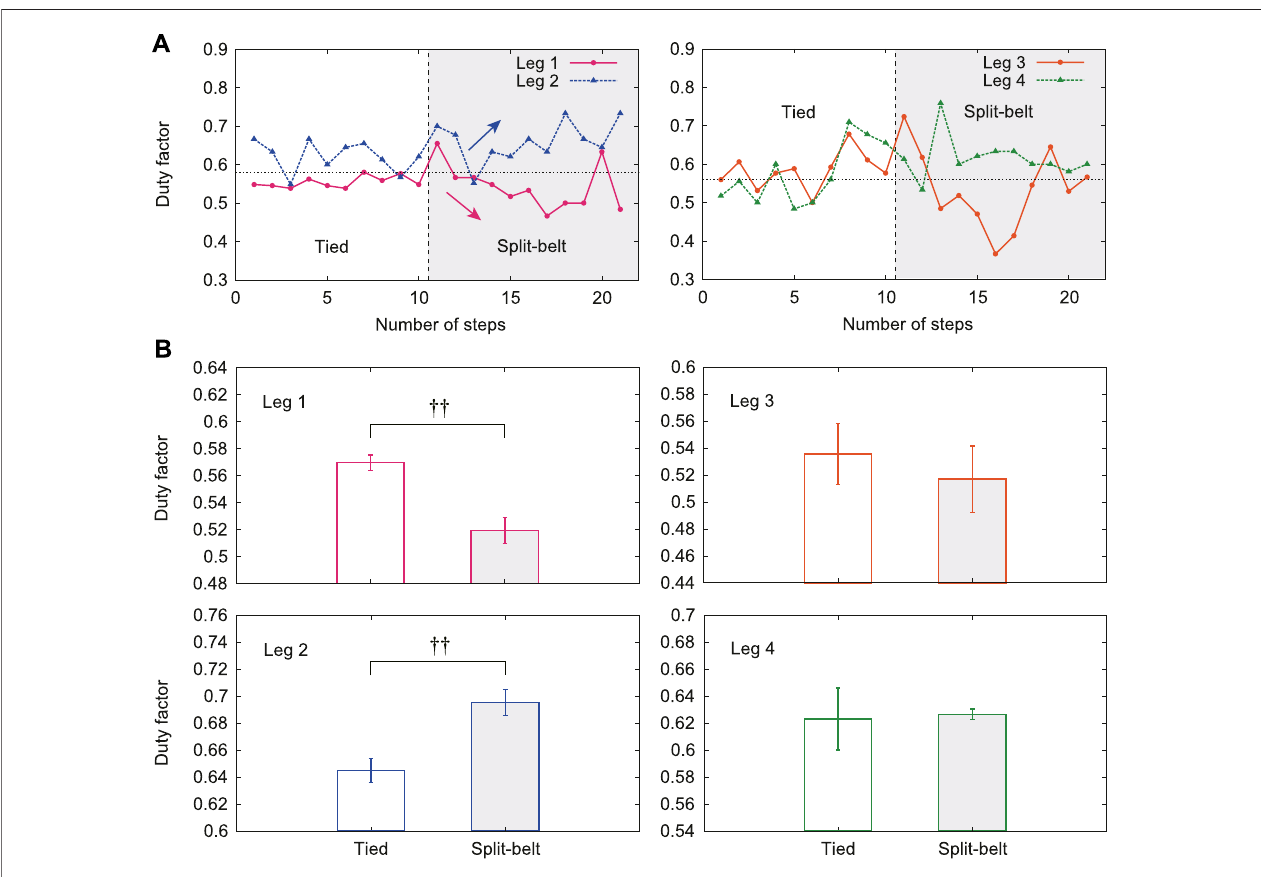
FIGURE 5 | Duty factors with use of only spinal model. (A) Duty factors for Legs 1 – 4 for one representative trial of 5x condition. (B) Their averages for tied and split-belt con fi gurations. Data points and error bars are the mean and standard error results of fi ve experiments, respectively. †† : p < 0 . 01.